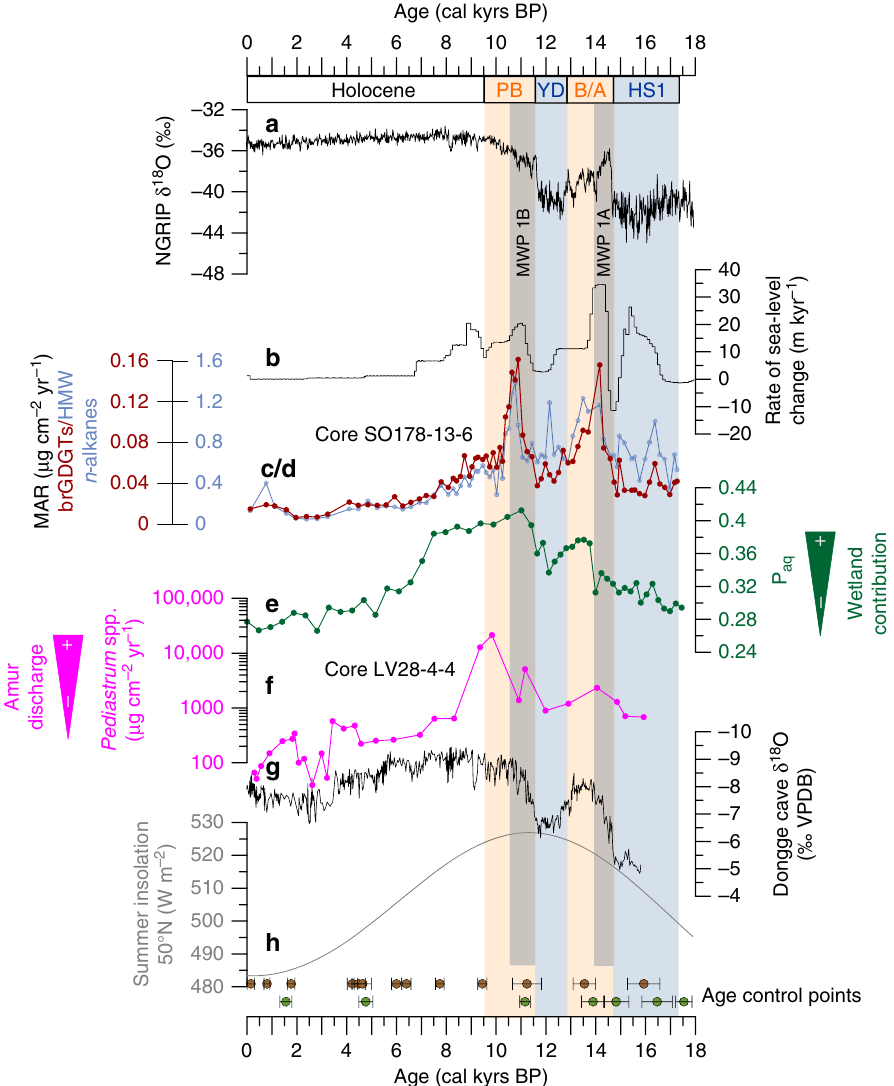
Fig. 2 Proxies for terrigenous organic matter mobilization compared with records of deglacial environmental changes. a Greenland NGRIP δ 18 O 68 ; b rate of global sea-level change 14 ; biomarker records obtained from sediment core SO178-13-6, mass accumulation rate (MAR) of c branched glycerol dialkyl glycerol tetraethers (brGDGTs) and d high molecular weight (HMW) n -alkanes (C 27 , C 29 , C 31 and C 33 ); e P aq ratio 25 from nearby core XP07-C9 26 ; f accumulation rate (AR) of chlorophycean freshwater algae Pediastrum spp. from core LV28-4-4, note the logarithmic scale; g speleothem δ 18 O record from Dongge cave as indicator for East Asian summer monsoon intensity, which controls precipitation in the Amur Basin 23 ; h summer insolation at 50°N. Circles at the bottom show age control points (AMS 14 C dates) with 2 σ uncertainties for cores LV28-4-4 (brown) and SO178-13-6 (green) 46 . Orange boxes highlight the warm phases Bølling-Allerød (B/A) and Pre-Boreal (PB), the Younger Dryas cold spell (YD) and Heinrich Stadial 1 (HS1) are marked in blue; grey boxes mark the periods of melt water pulse 1 A (MWP-1A) and